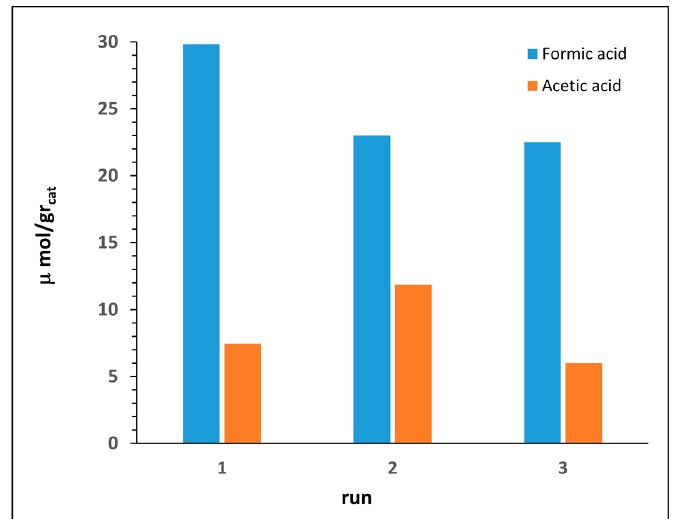
Figure 7. Recycling of photocatalyst nanocomposite 4C .